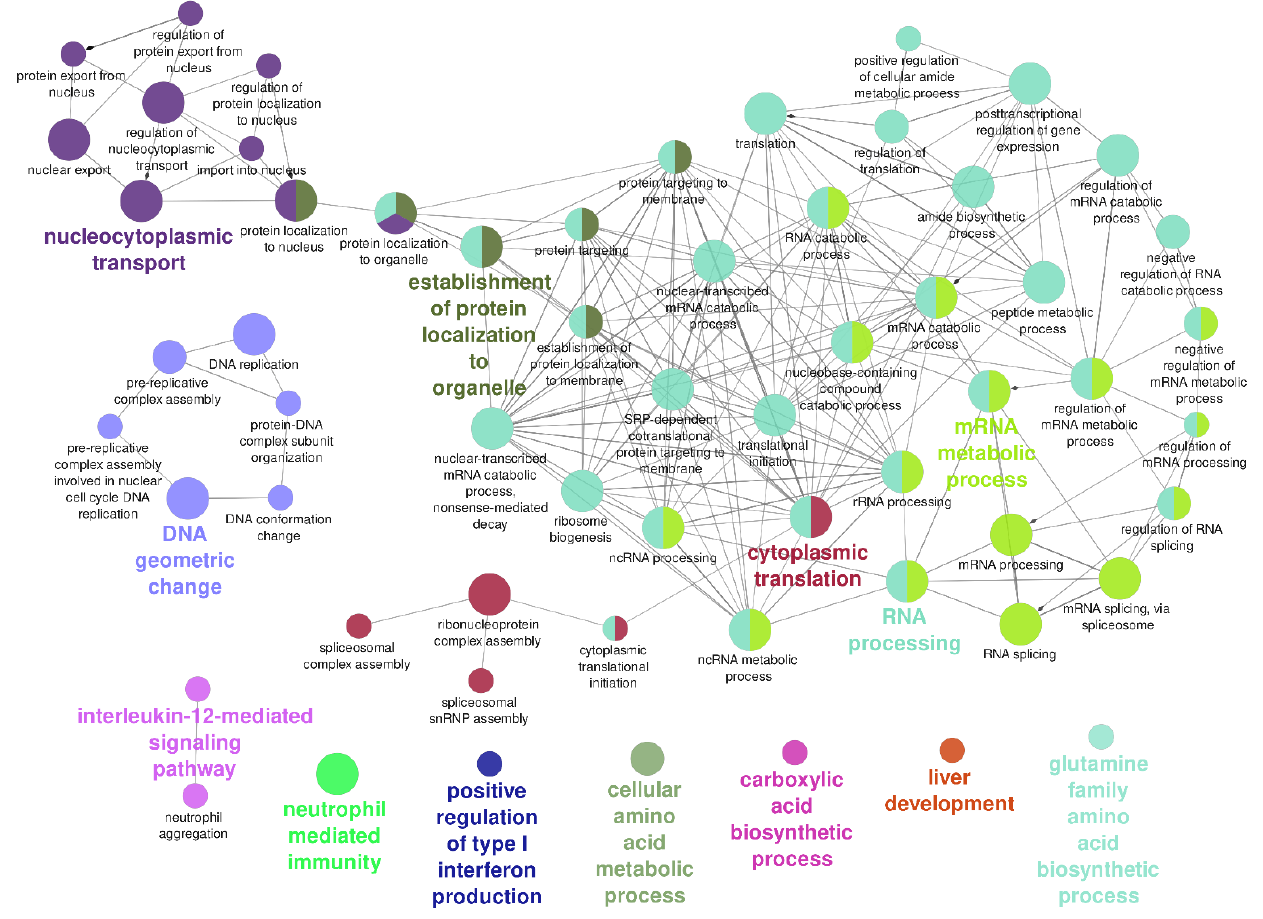
Figure 4. Interaction network of enriched biological processes obtained from the 265 unique proteins labeled in TIA1-APEX2 in both unstressed and sodium arsenite-treated cells. GO terms are represented as nodes, and the node size represents enrichment significance. The color of the nodes changes depending on the functional groupings and cluster distribution. The network was visualized in Cytoscape running the ClueGo plugin using a yFiles organic layout.